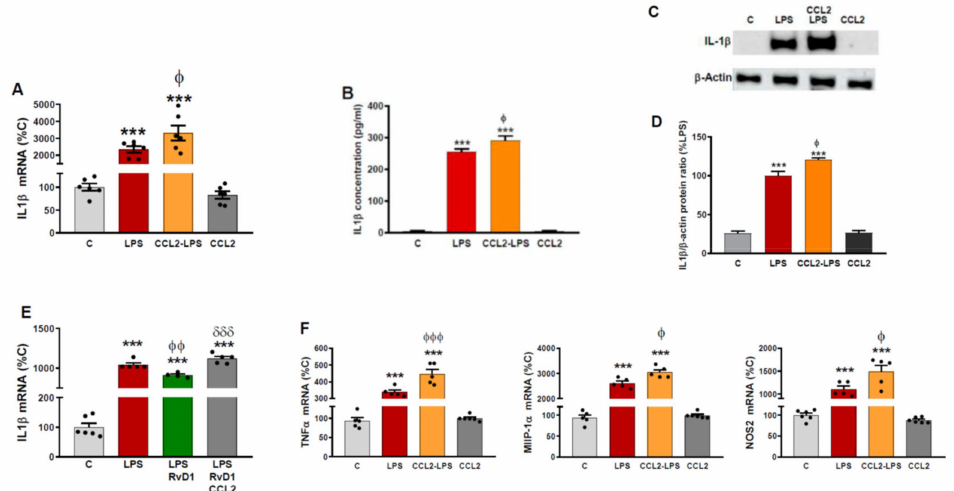
Figure 3. CCL2 induces production of astrocytic inflammatory markers. ( A ) Astrocyte cultures were incubated with or without CCL2 (100 ng/mL). Twenty-four hours later, the whole medium was replaced in all wells, maintaining CCL2 where it was used for pre-treatment and adding LPS (0.1 g/mL) to indicated groups. Forty-eight hours later, RNA was isolated and IL-1 β mRNA levels determined by RT-PCR. Data are means ± SEM of n = 6 replicates per group. *** p < 0.001 vs. C-C. φ p < 0.05 vs. LPS. ( B ) IL-1 β concentration in the media was measured by ELISA. Data are means ± SEM of n = 6 replicates per group. *** p < 0.001 vs. C. φ p < 0.05 vs. LPS. ( C ) Cytosolic lysates were examined for the presence of IL-1 β and β -actin protein by Western blot analysis. The gels shown are representative of experiments done on three separate astrocyte preparations. ( D ) Densitometric analysis of the bands. AU: arbitrary units relative to C. *** p < 0.001 vs. C. φ p < 0.05 vs. LPS. ( E ) Astrocyte cultures were incubated with vehicle (EtOH 0.037%), RvD1 100 nM (dissolved in EtOH 0.037%) or RvD1+CCL2 (100 ng/mL). Twenty-four hours later, the whole medium was replaced in all wells, maintaining RvD1 and CCL2 where it was used for pre-treatment and adding LPS (0.1 g/mL) to all groups except the control one. Forty-eight hours later, RNA was isolated and IL-1 β mRNA levels determined by RT-PCR. Data are means ± SEM of n = 6 replicates per group. *** p < 0.001 vs. C. φφ p < 0.01 vs. LPS. δδδ p < 0.001 vs. LPS+RvD1. ( F ) Astrocyte cultures were incubated with or without CCL2 (100 ng/mL). Twenty-four hours later, the whole medium was replaced in all wells, maintaining CCL2 where it was used for pre-treatment and adding LPS (0.1 g/mL) to indicated groups. Forty-eight hours later, RNA was isolated and TNF α , MIP1 α and NOS2 mRNA levels determined by RT-PCR. Data are means ± SEM of n = 6 replicates per group. *** p < 0.001